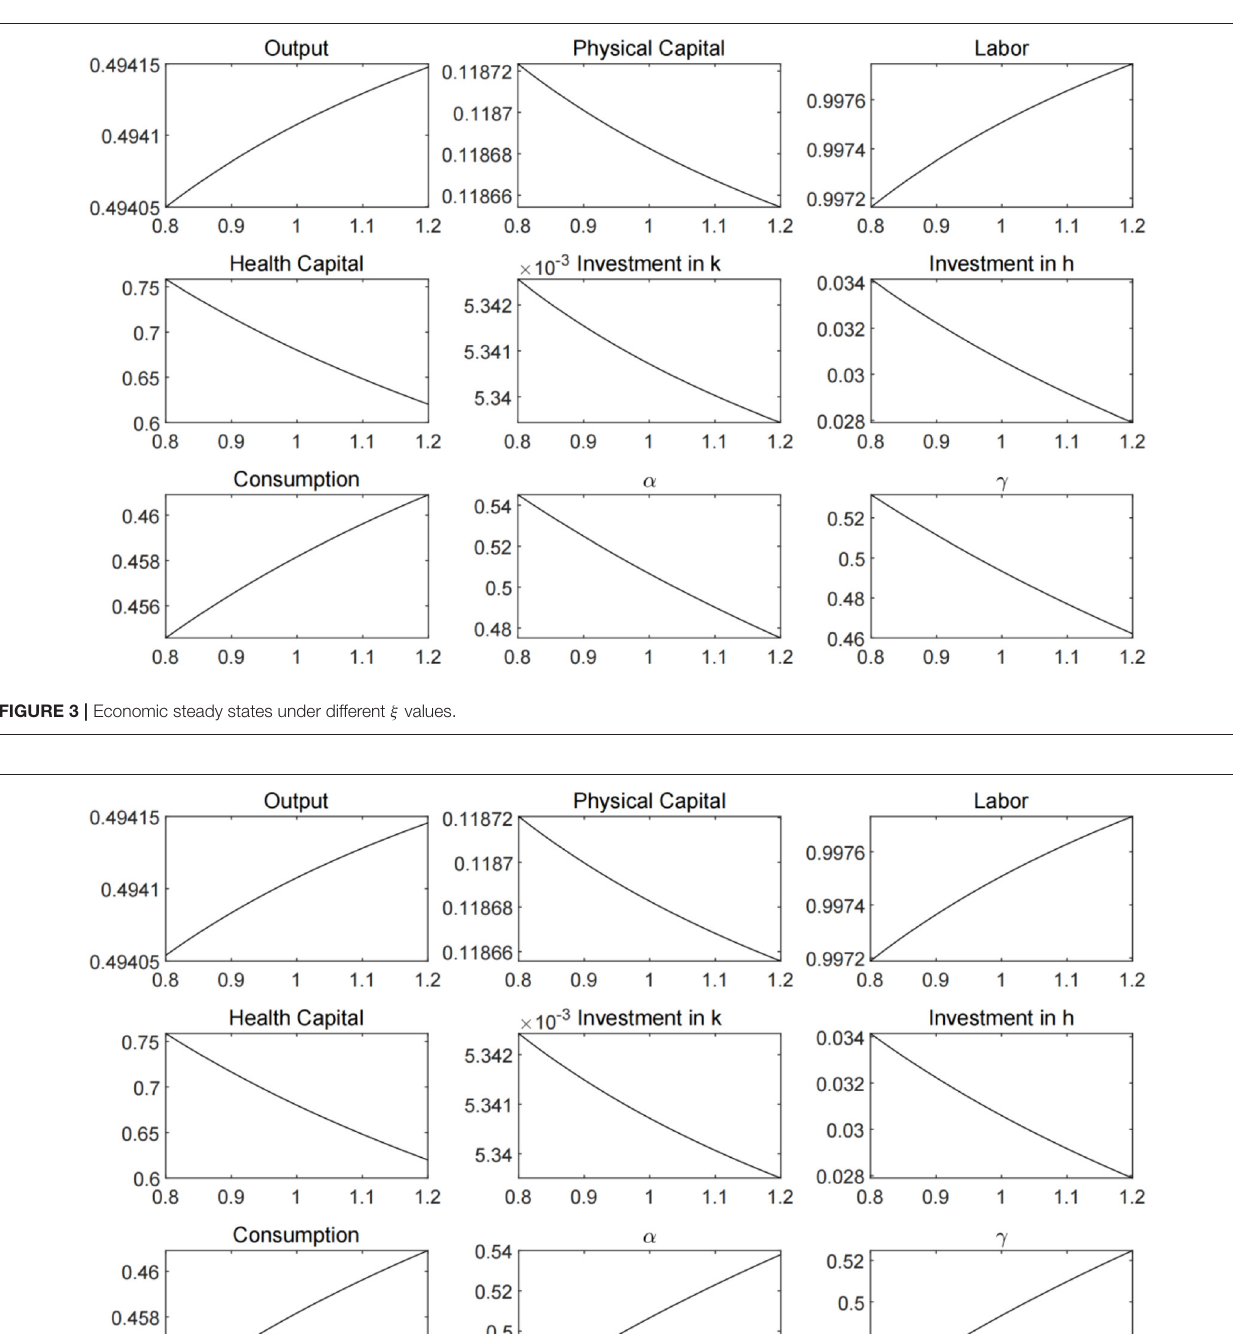
labor supply and economic output. Therefore, we need to further analyze the different combinations of public health policy